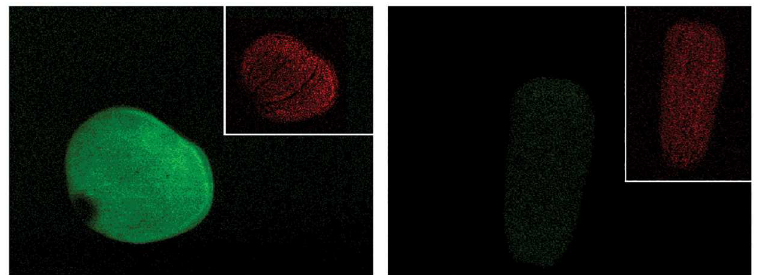
Fig 2. ROS production in larvae of P . astreoides . ROS production is shown as green fluorescence in the coral larvae. Left panel is a larva that was incubatedin seawaterat 30.5˚C and the right panel is a larva incubatedat 27˚C, both for 4.5 hours. The larvae are capableof muscular contraction, which enablesthem to elongate and compress. The images represent two specimensimagedin the same orientationjust under different contractionphases, reflecting the plasticity of coral larval morphology. Inset in both panels is the red chlorophyll autofluorescence of the symbiotic zooxanthellae. The two larvae displayedare typical of the sampledgroups (n =